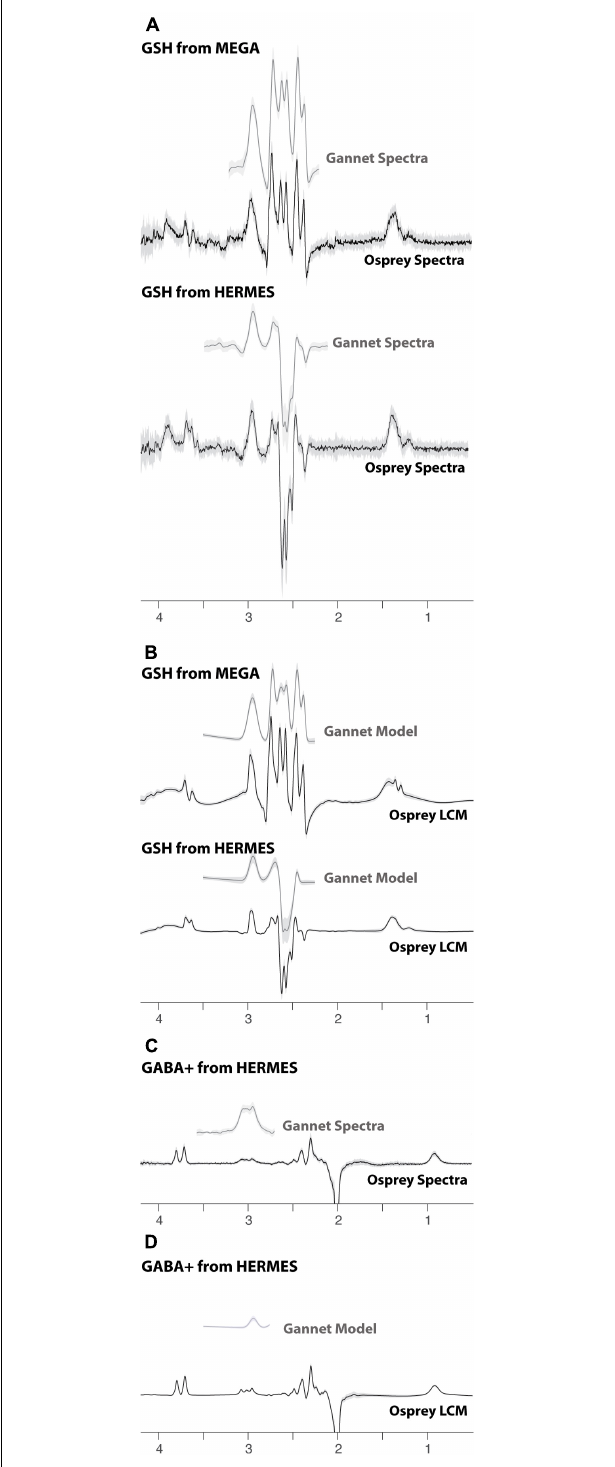
FIGURE 3 | Edited difference spectra and models, using Gannet (gray) and Osprey (black) software. (A) Summary of GSH-edited data. (B) Summary of GSH models. (C) Summary of GABA+-edited data. (D) Summary of GABA+ models. The solid lines represent the group mean, and the shaded area represents the range of mean ± one